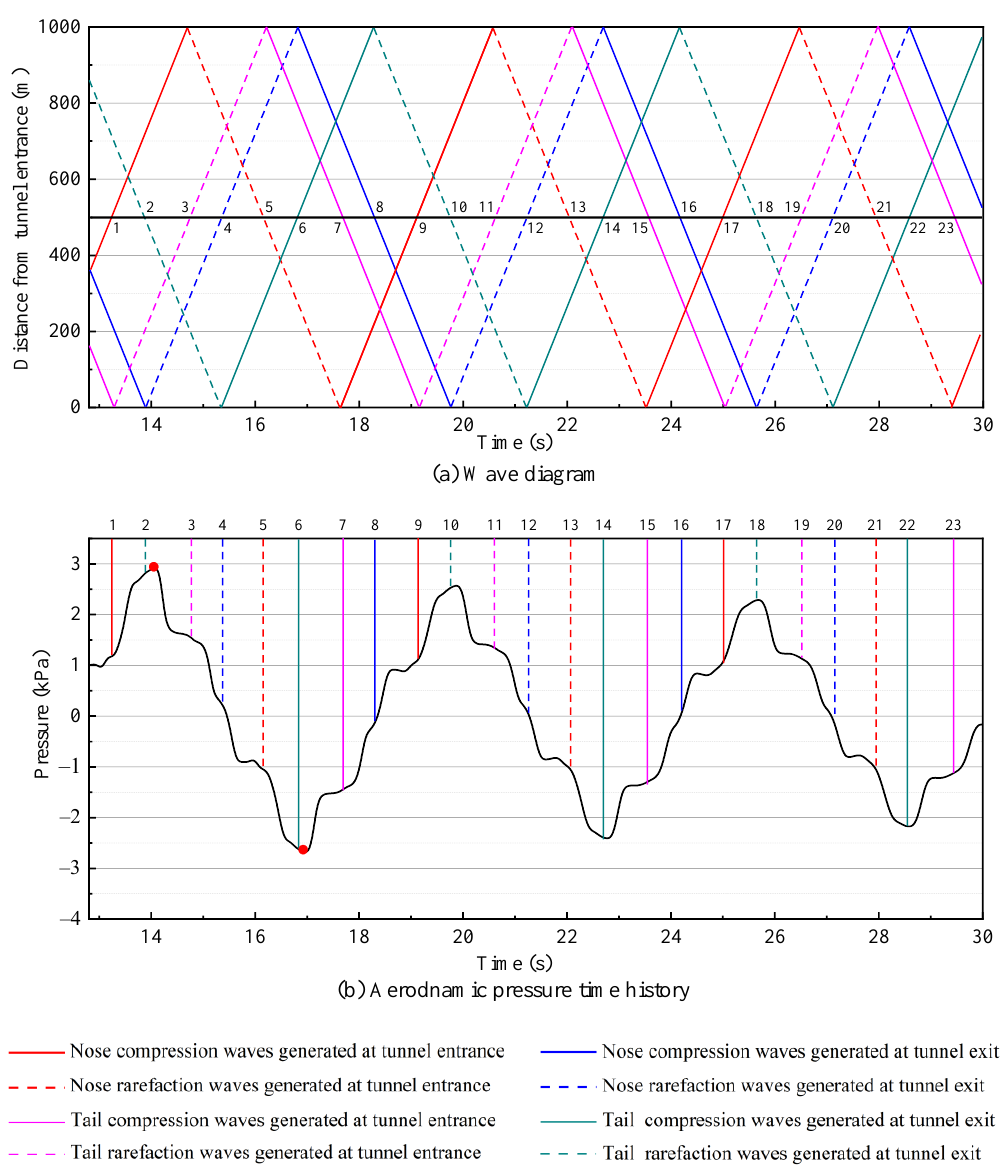
Figure 19. Wave diagram and aerodynamic pressure time history of monitoring point 10-V in Stage III at train speed of 350 km/h.